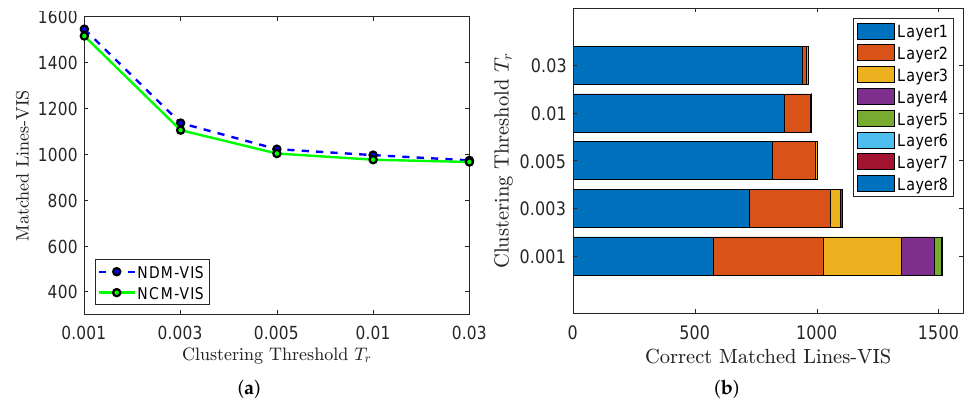
Figure 8. The influence of different T r on algorithm performance on the VIS dataset. ( a ) NDM and NCM of the VIS dataset, ( b ) layer distribution of the VIS